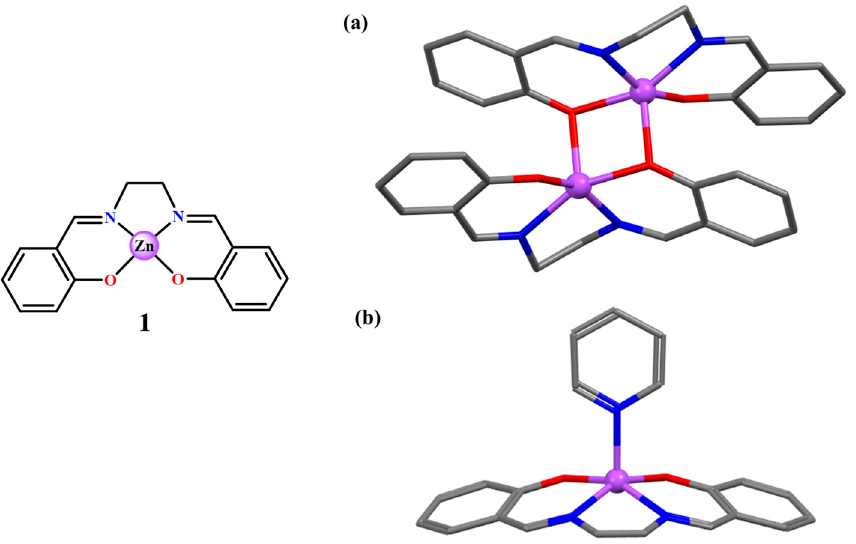
Figure 2. Molecular drawing of the Zn(salen) complex 1 , and crystal structures of the ( 1 ) 2 dimer ( a ) and the 1 ·py adduct ( b ). Adapted from Refs. [15,16].